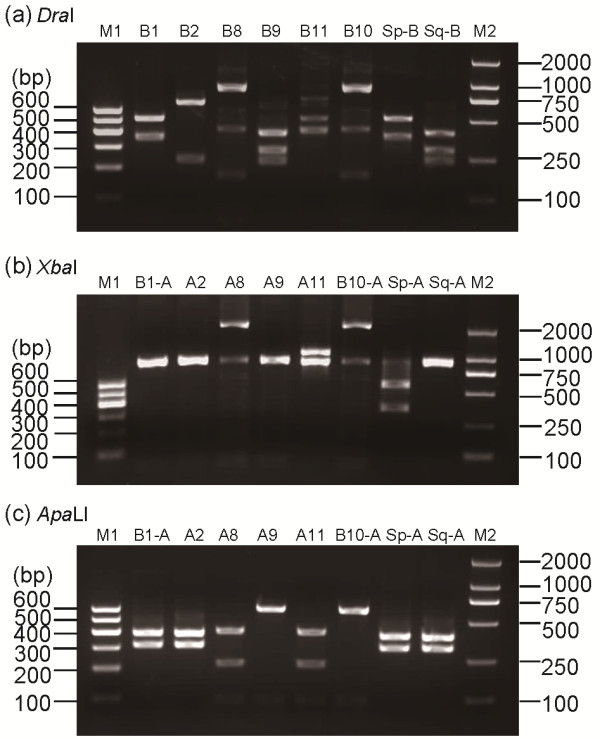
 (a)DraI and (b)XbaI PCR-RFLP profiles of esterase B and (c)ApaLI PCR-RFLP profiles of esterase A from standard C. pipiens complex strains. M1, Marker I. M2, Marker D2000. The standard strains are the same as those described in Figure 1.